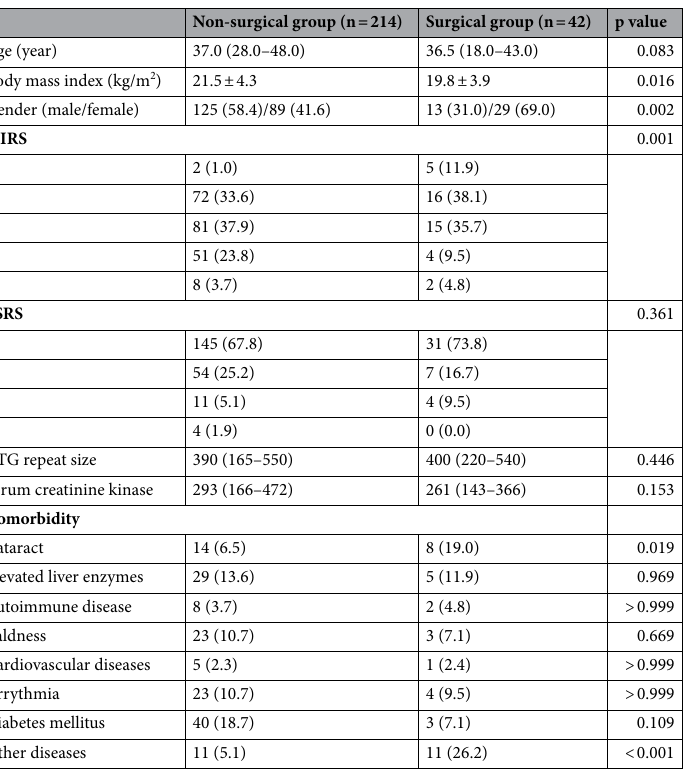
Table 1. Clinical characteristics of the patients with a myotonic dystrophy type 1. Data are expressed as mean (standard deviation), number (%), or median (interquartile range). MIRS muscular impairment rating scale, FSRS functional status rating scale, CTG cytosine-thymine-guanine, Other diseases Bronchiectasis, myoma, biliary atresia, cryptorchism, hydrocephalus, neurofibroma, and vocal cord